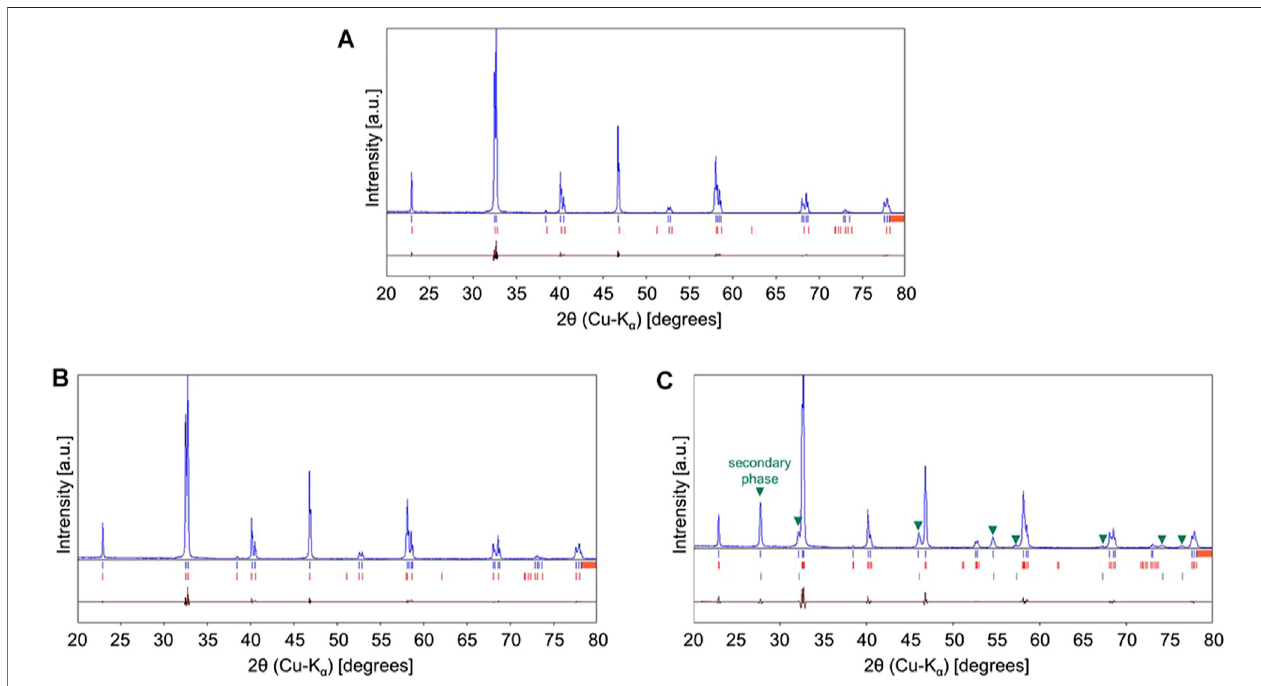
FIGURE 1 | XRD patterns of La 0.7 Sr 0.3 Mn 0.9 X 0.1 O 3 [X = (A) Mn (non-substituted LSM), (B) Co-substituted LSM, and (C) Ce-substituted LSM]. The blue and red vertical bars below the XRD pattern corresponded to peak positions of sample and crystalline phase in the reference, respectively. The signal pattern of dark red represented the relative difference of intensity between the sample and reference in the Rietveld re fi nement.